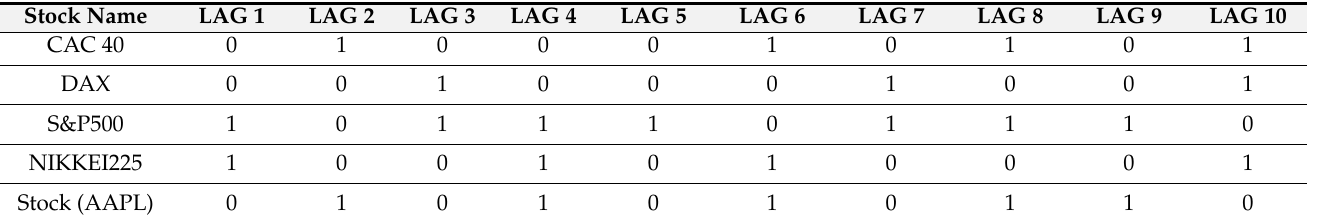
Table 9. A sample of one chromosome returned by the genetic algorithm feature to forecast AAPL for a single rolling